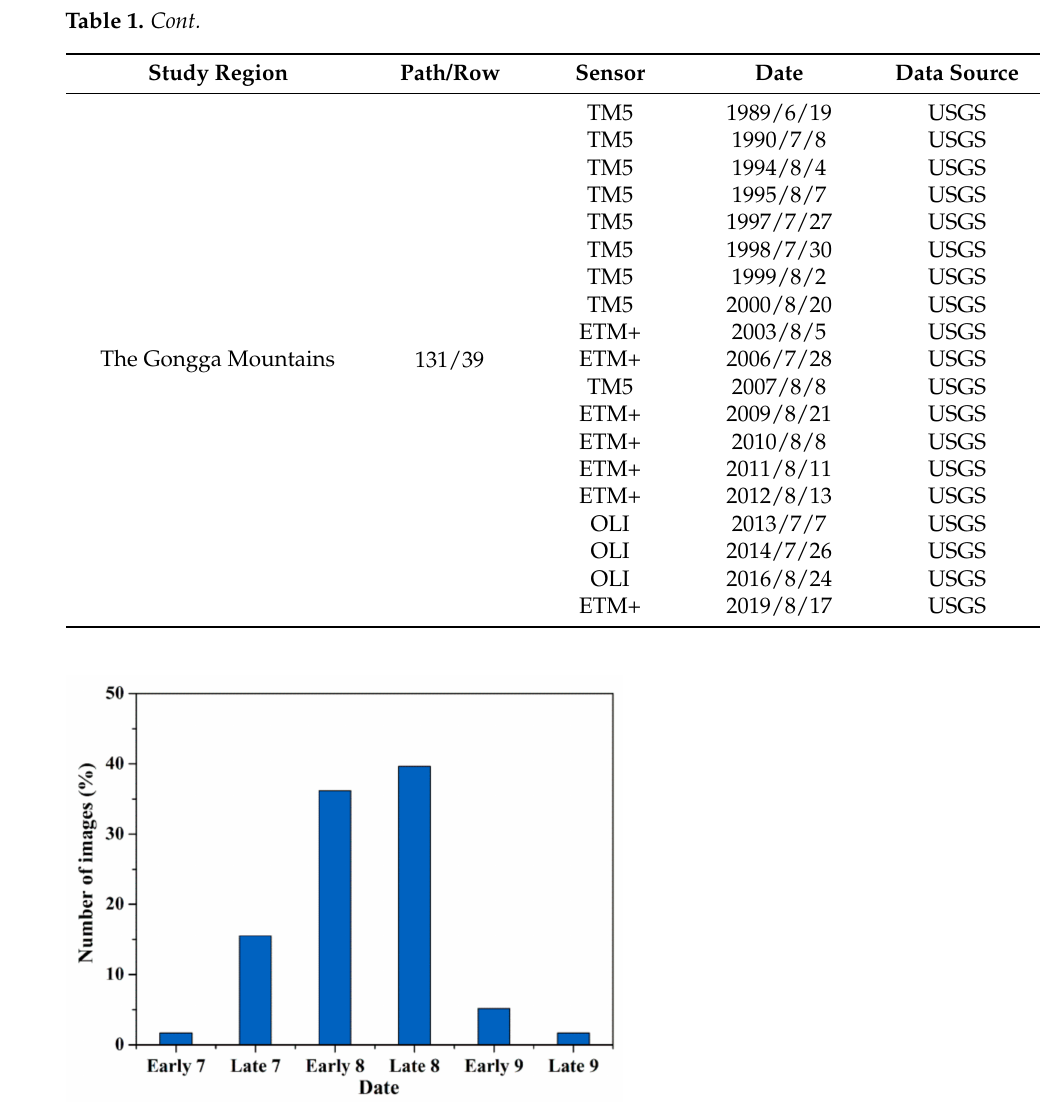
Figure 2. Temporal distribution of the selected Landsat images to derive